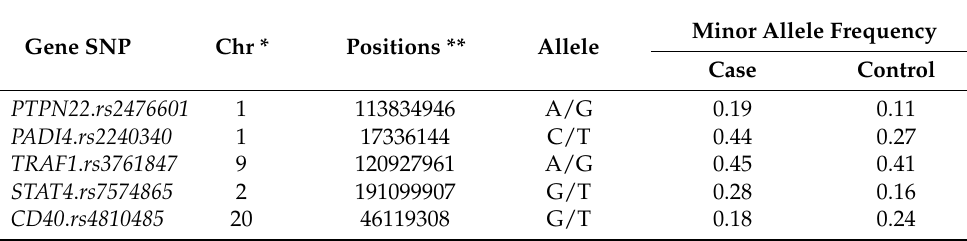
Table 3. Basic information and allele frequencies of the 5 selected SNPs in PTPN22 , PADI4 , TRAF1 , STAT4, and CD40